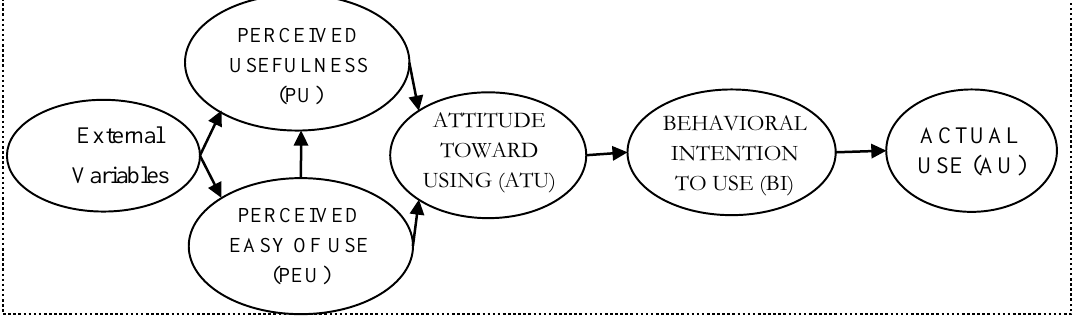
Figure 1. Technology Acceptance Model (TAM) original proposal [32].